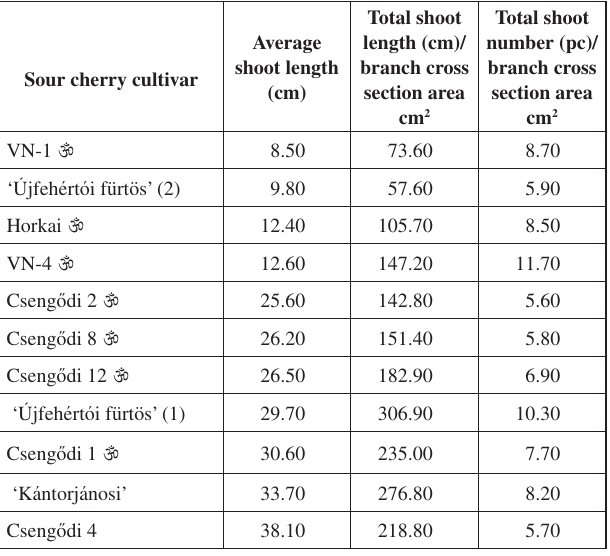
Sour cherry cultivar